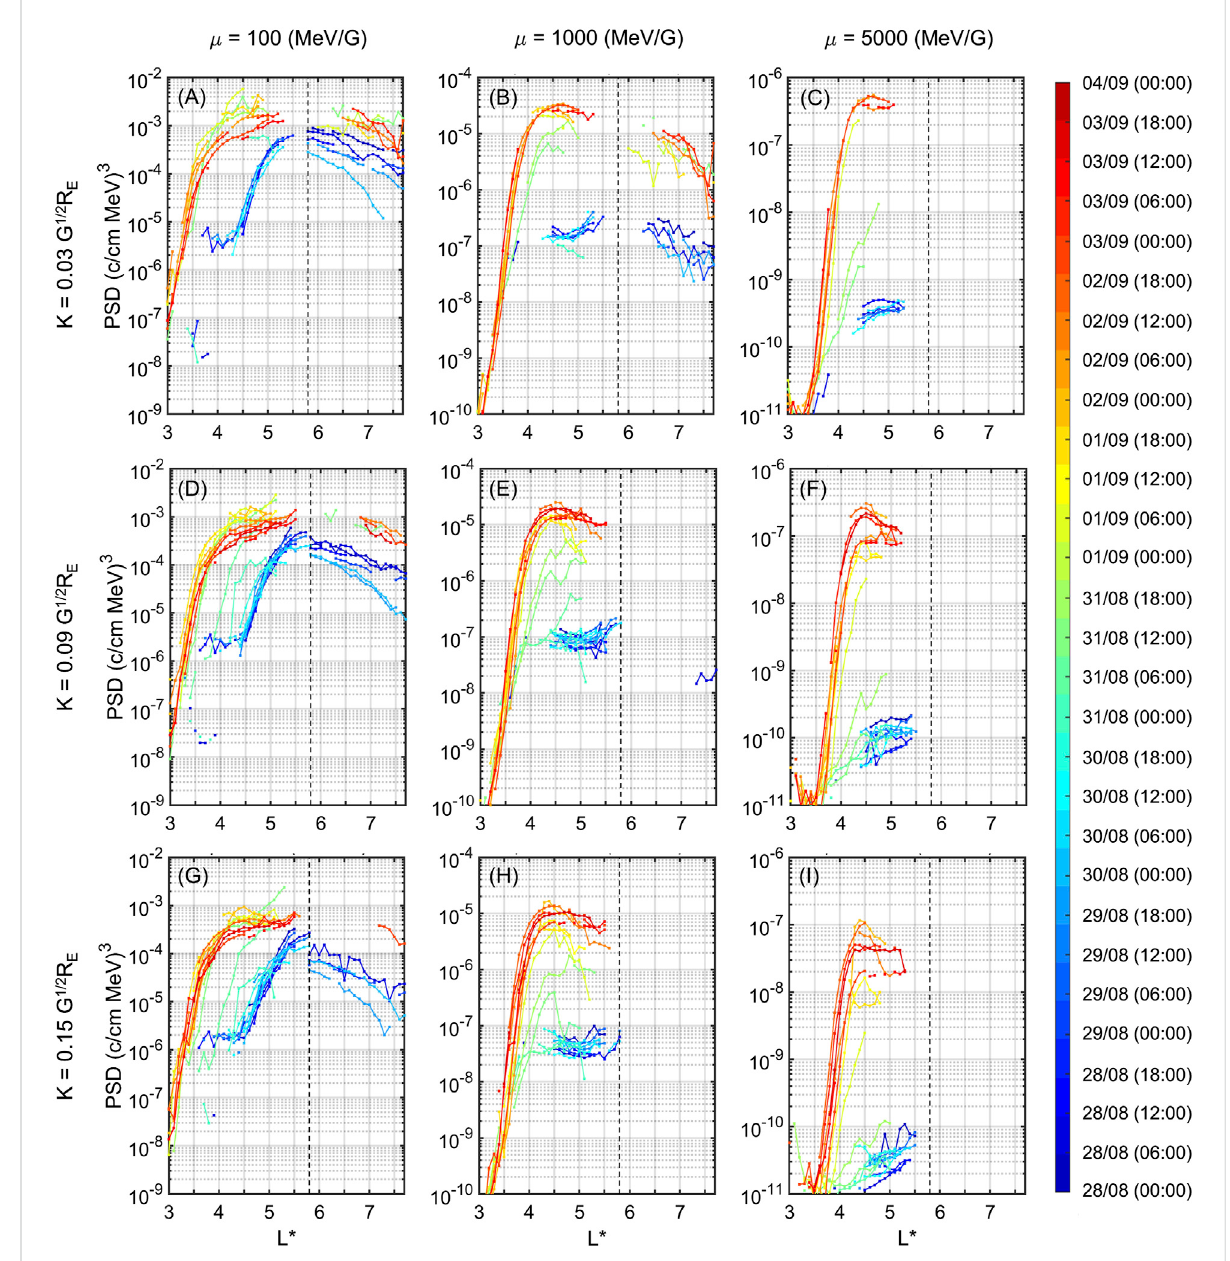
The radial pro fi les of theelectron Phase Space Density (PSD), using data from the Van Allen ProbeA and the Arase satellite for L* = 3 – 5.8 R E (on theleftoftheverticaldashedlines)andfromtheTHEMISA,D,andEsatellitesforL*=5.8 – 7.8R E (ontherightoftheverticaldashedlines)forselected dates of the third CIR group, during 28/8 – 4/9/2019. From top to bottom, the values of K = 0.03, 0.09, and 0.15 G 1/2 R E are presented [panels (A,B,C) , (D,E,F) , and (G,H,I) , respectively]. From left to right, the values of μ = 100, 1,000, and 5,000 MeV/G are presented [panels (A,D,G) , (B,E,H) , and (C,F,I) ,respectively].ThefastestCIRofthethirdCIRgrouparriveson30/8,12:00.TheTHEMISPSDispresentedheredividedbyafactoroftwofor μ = 100 MeV/G and divided by a factor of six for μ = 1,000 MeV/G. These values were selected based on the K = 0.03 G 1/2 R E plots, in order to achieve a good alignment of the